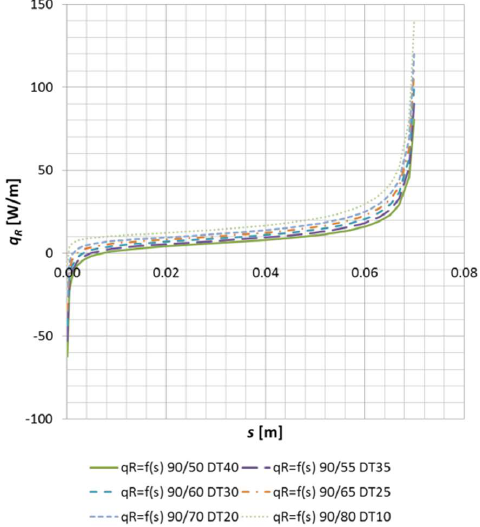
Figure 4. The dependence of the unit heat flux of the return pipe as a function of the distance between the pipes at different return temperatures ( q R = f(s, T R ) ).